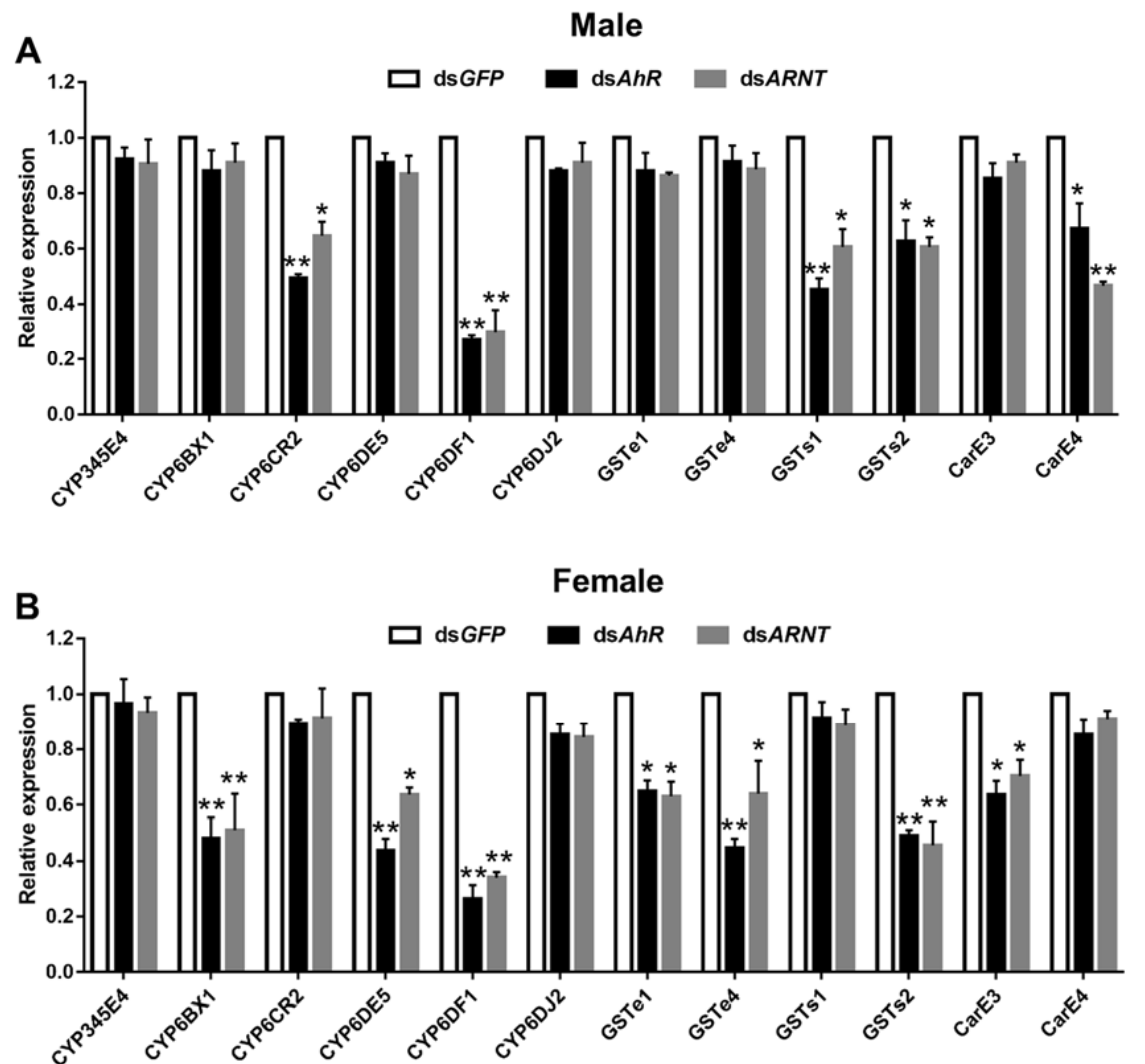
Figure 6. RT-qPCR analyses of the expression of 12 detoxification genes after silencing AhR ( A ) and ARNT ( B ) in D. armandi adults. The relative expression levels were normalized with β -actin and CYP4G55 . The asterisk indicates a significant difference between treatment groups (* p < 0.05, ** p < 0.01, independent Student’s Test). All values are mean ± SE , n = 3.